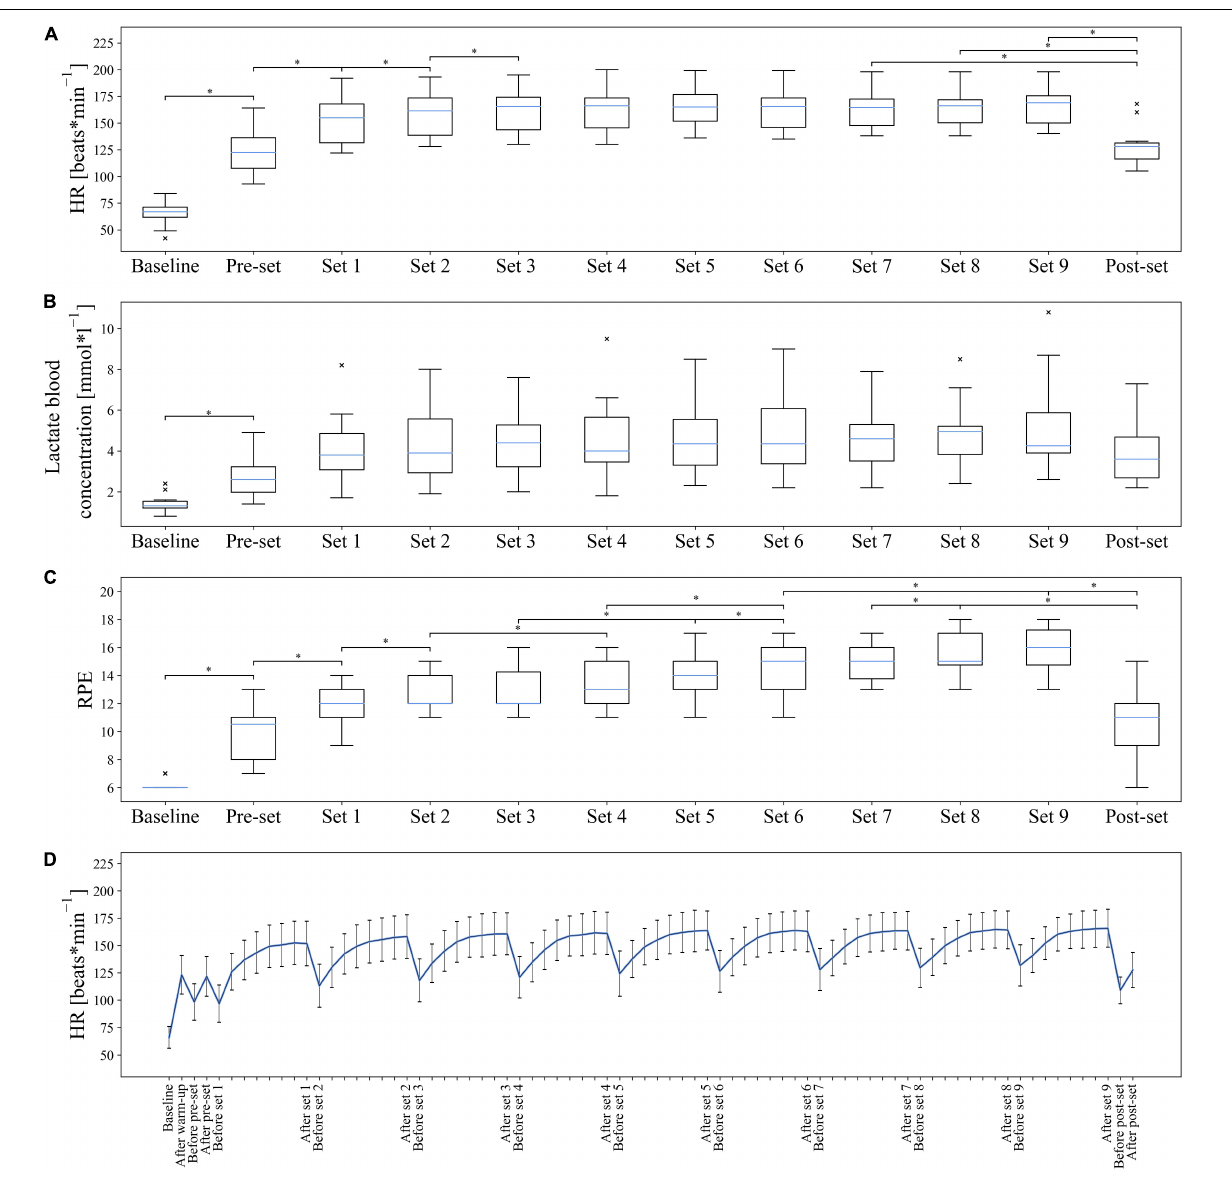
FIGURE 6 | Development of HR, lactate blood concentration, and RPE over the duration of the examination. Values are considered as outliers if they are outside the interval [ Q concentration, and RPE showed significant results. For reasons of clarity, only significant adjacent pairs of post hoc comparisons are shown. If the difference to the nearest neighbor was not significant, the difference to the next but one neighbor was shown. If this difference was not significant either, the next neighbor was shown. An overview of all post hoc comparisons is presented in Supplementary Table S1 . (D) The mean values and SDs of the continuous HR curve are